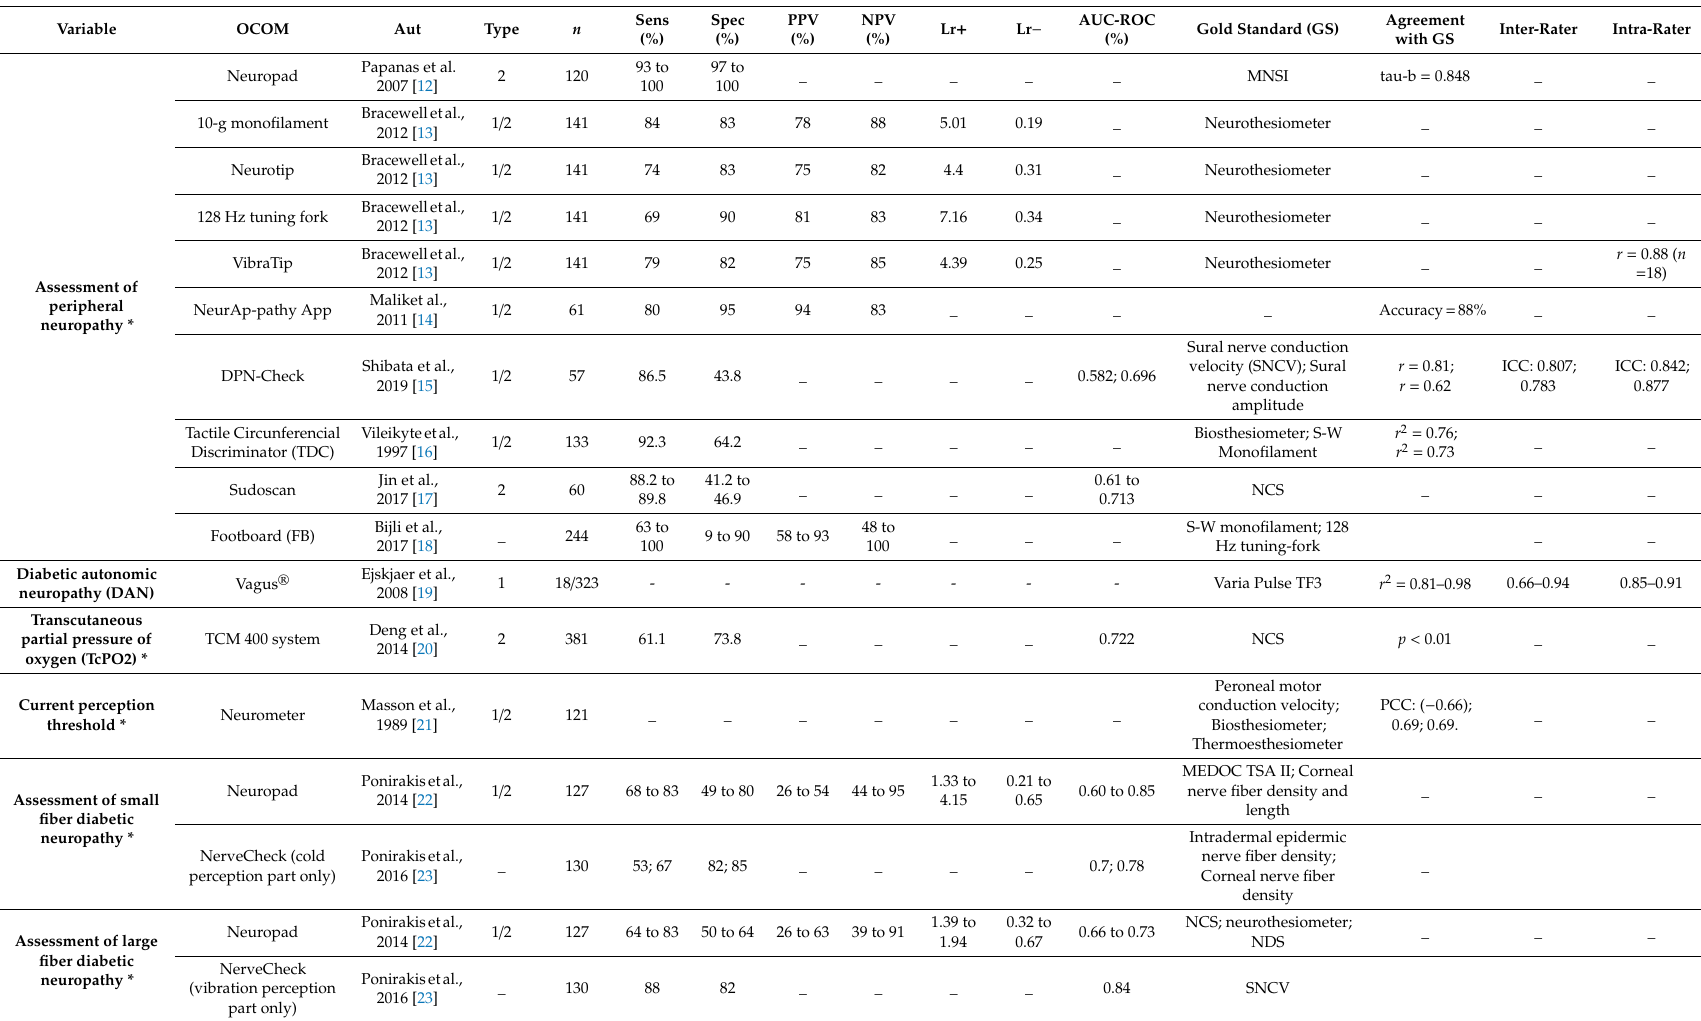
Table 1. Variables related to diabetic neuropathy and the objective clinical outcome measures (OCOMs) validated for their assessment. Variable